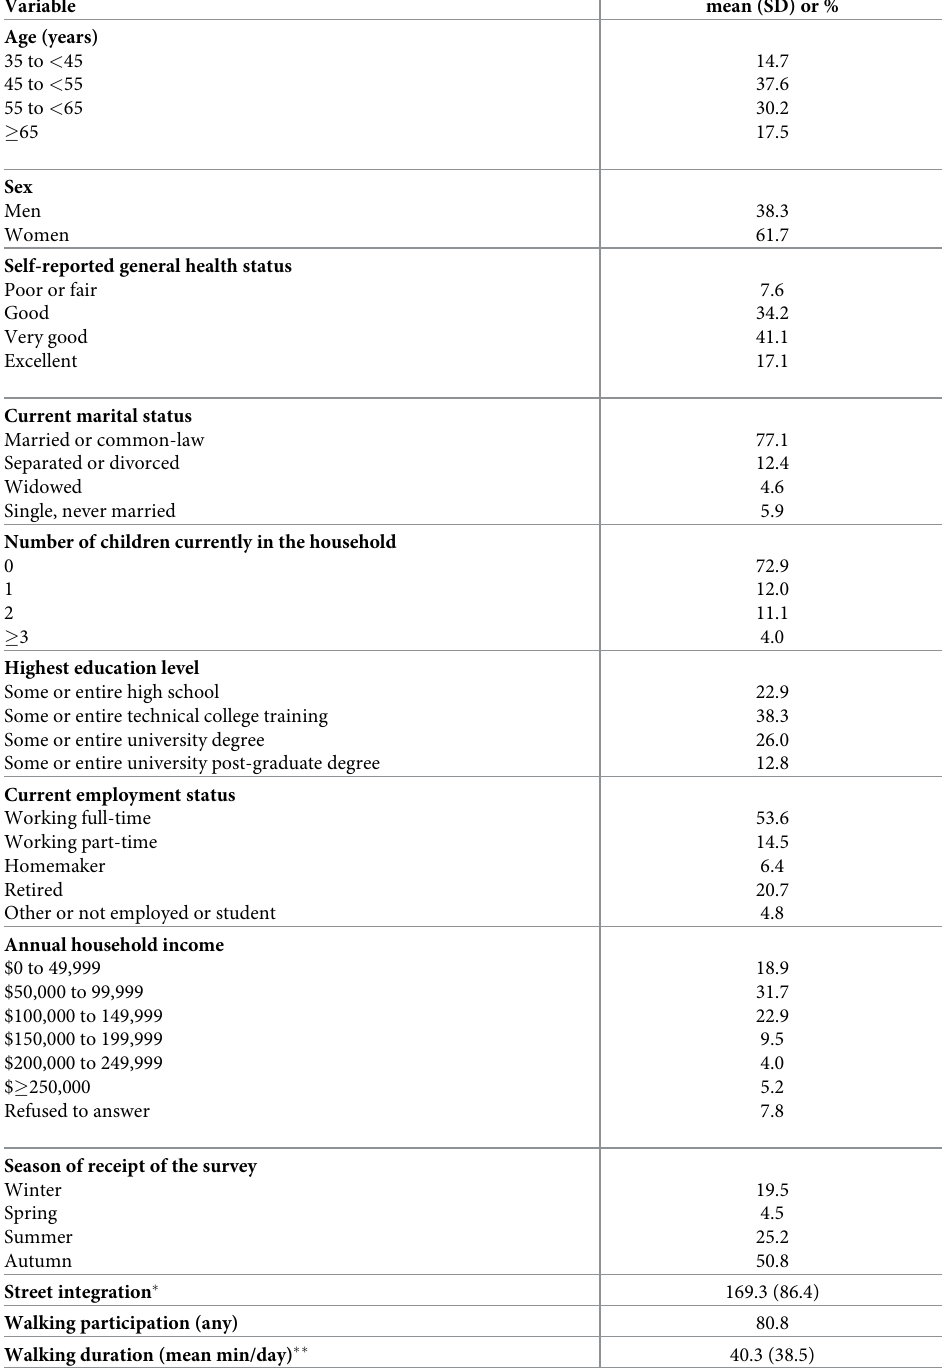
Table 1. Descriptive characteristics for participants (n =